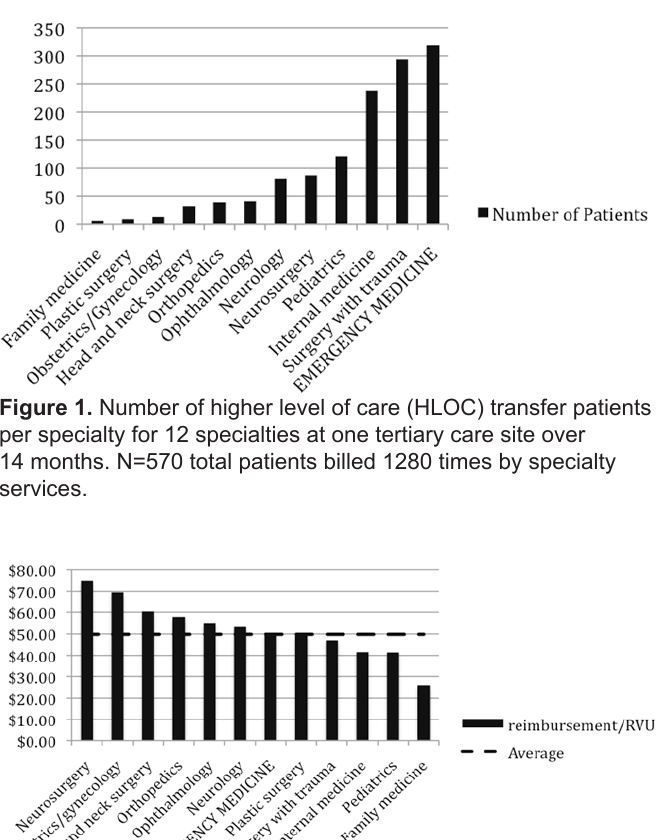
gynecology (Table 1) (e.g. normal spontaneous vaginal delivery= 26.80 work RVU). EM had 6.49 RVU per patient (e.g. evaluation and management code level 5= 3.80 RVU). 10